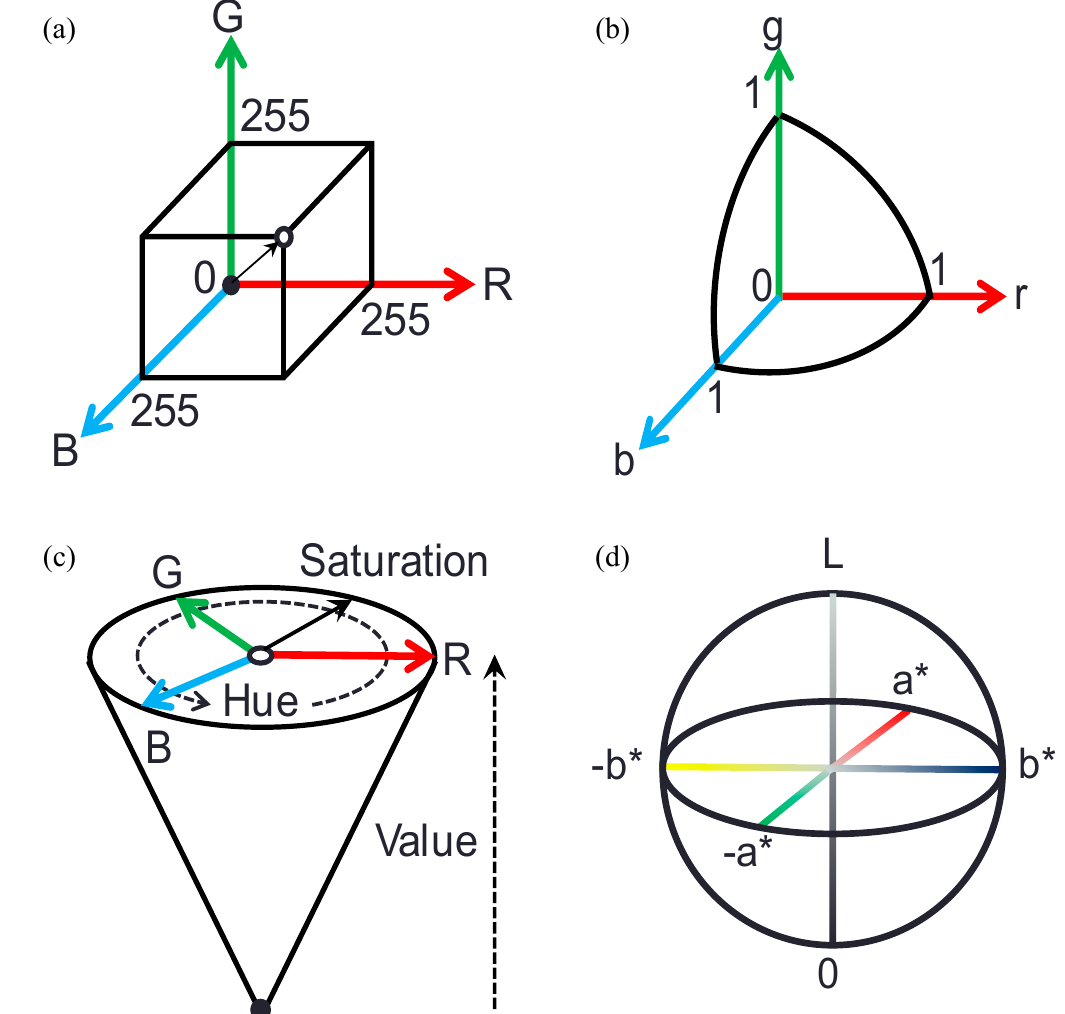
Figure 3. Color spaces in three-dimensional coordinate systems: ( a ) ‘RGB’, ( b ) ‘rgb’, ( c ) ‘HSV’ and ( d ) ‘CIE La*b*’.